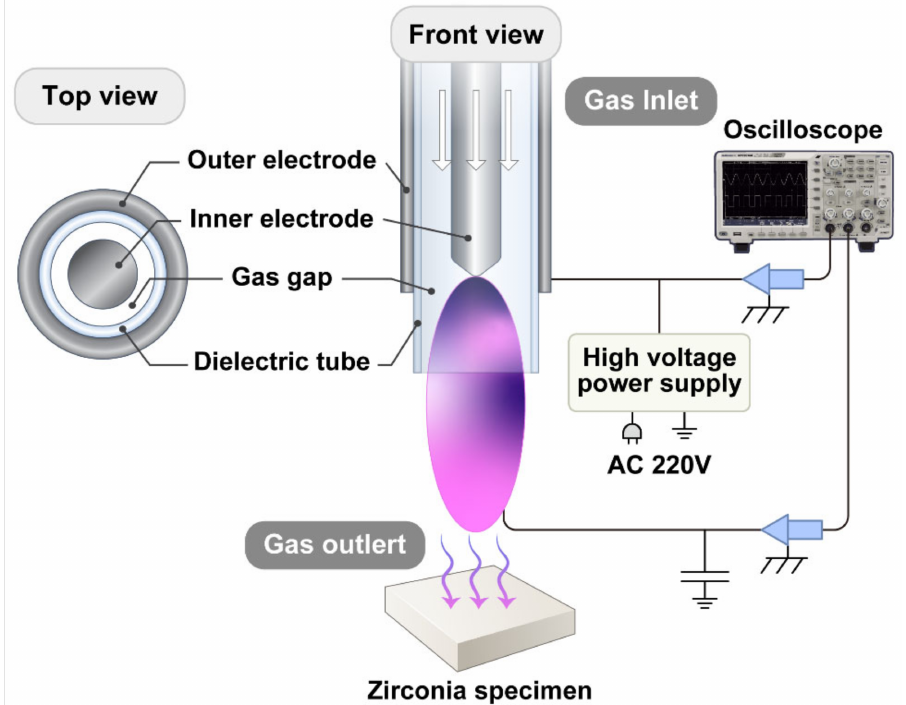
Figure 7. Schematic diagram of experimental setup for plasma surface